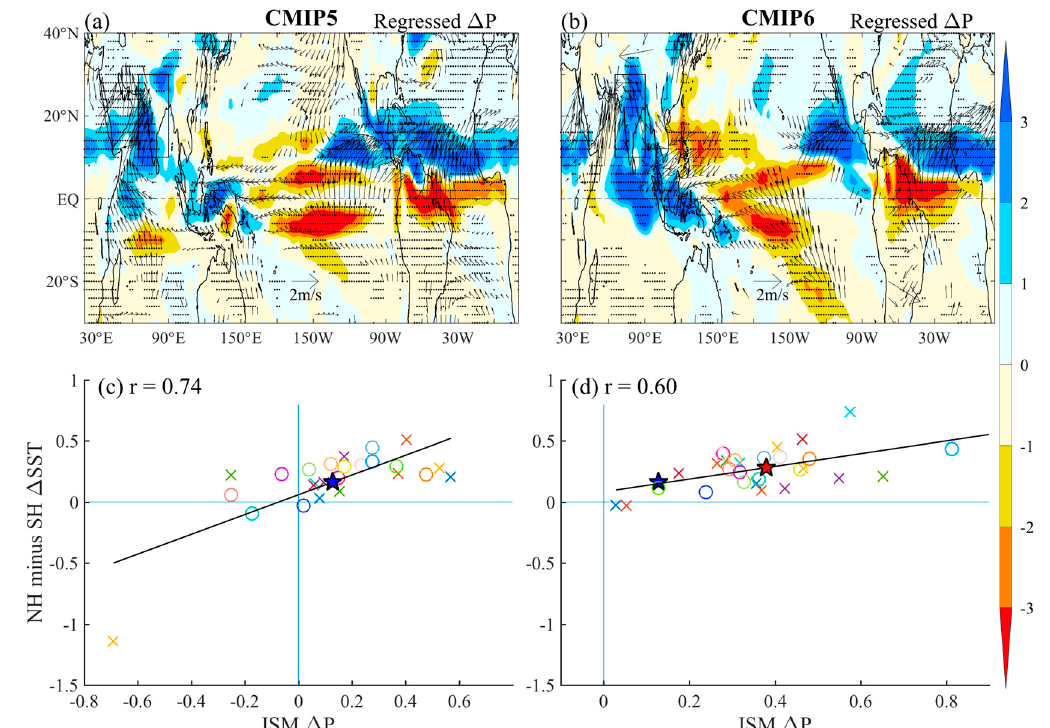
Figure 11. Spatial pattern of regressed precipitation change ( ∆𝑃 , shading, hPa/day) and 925 hPa winds (vectors, m s − 1 ) onto the NH minus SH surface warming contrast indices among models in ( a ) CMIP5 and ( b ) CMIP6. Note that only zonal or meridional winds significate at 90% confidence level are plotted. ( c ) and ( d ) are the scatterplots between ISM ∆𝑃 and NH minus SH surface warming contrast among models. The blue and red stars, respectively, indicate the CMIP5 and CMIP6 MME results.